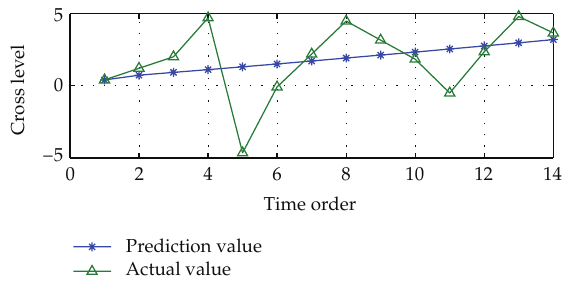
Figure 5: Comparison of actual value and prediction value at a fixed measuring point.